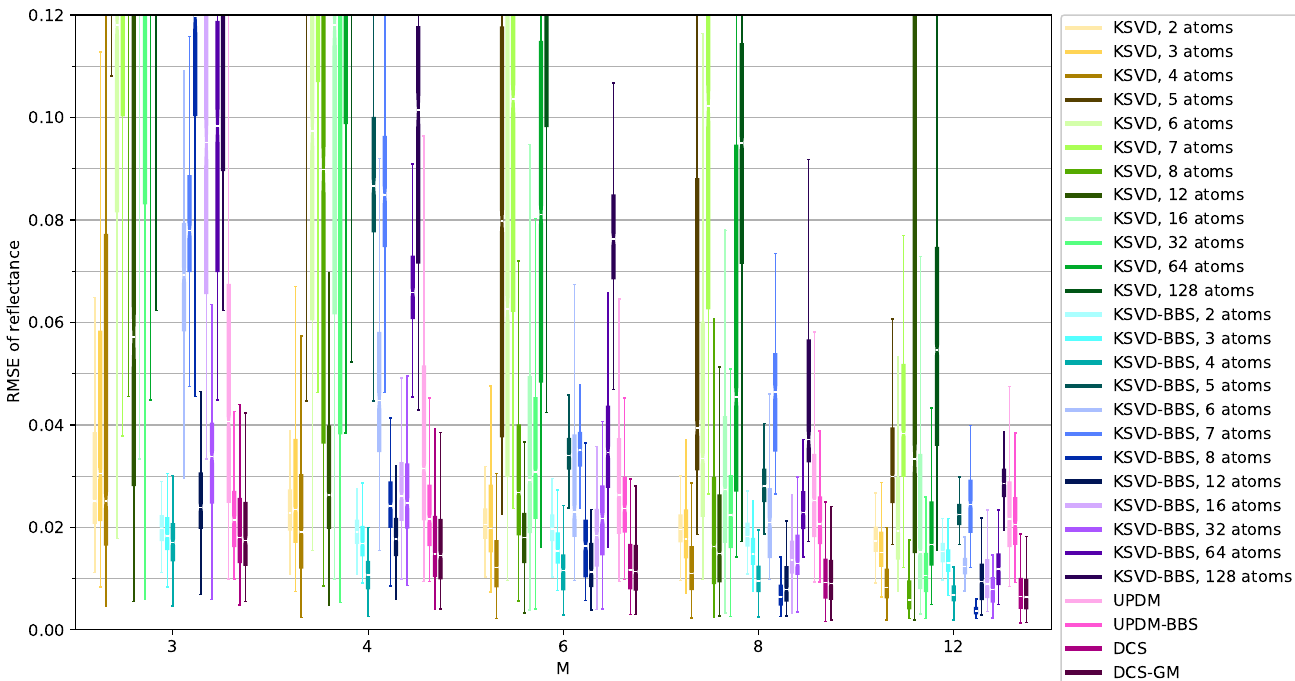
Figure 6. The evaluation results for all approaches on the training set Air_MA , band selection dataset Air_MB and evaluation dataset Ground_Full